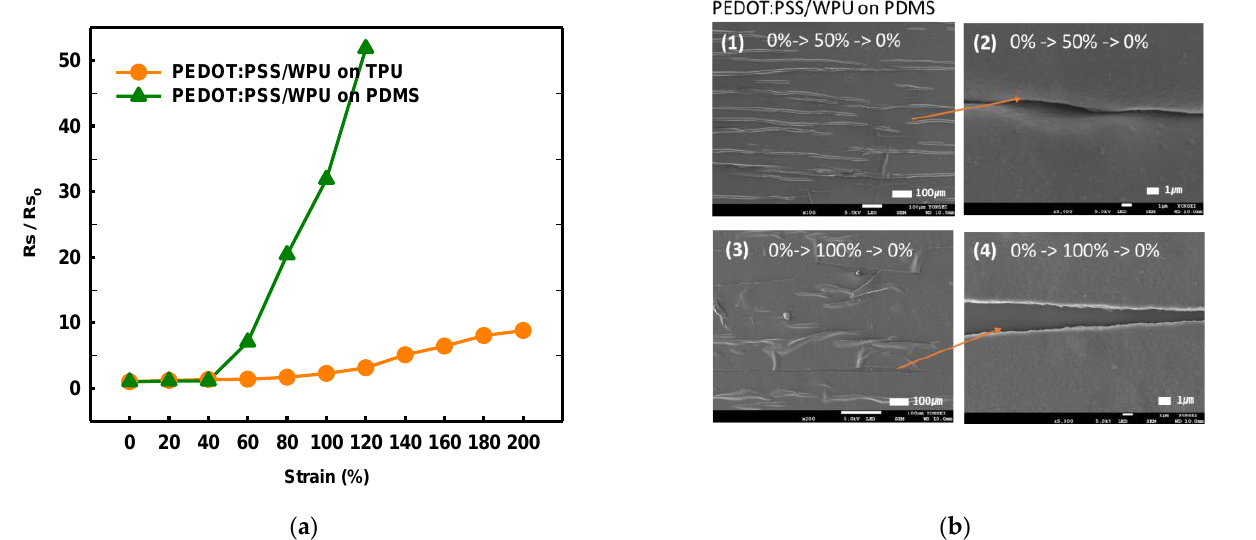
Figure 8. Scanning electron microscope (SEM) images of ( a ) PEDOT:PSS only and PE- DOT:PSS/nonionic WPU (0.5 wt%) coated on TPU substrate after strain and release with 20 and 50% strain. ( b ) PEDOT:PSS only and PEDOT:PSS/nonionic WPU (2.0 wt%) coated on TPU substrate after strain and release with 50 and 100% strain. ( 1 ) and ( 4 ) under 0% strain, ( 2 ), ( 3 ), ( 5 ) and ( 6 ) after one stretch-release different strains.